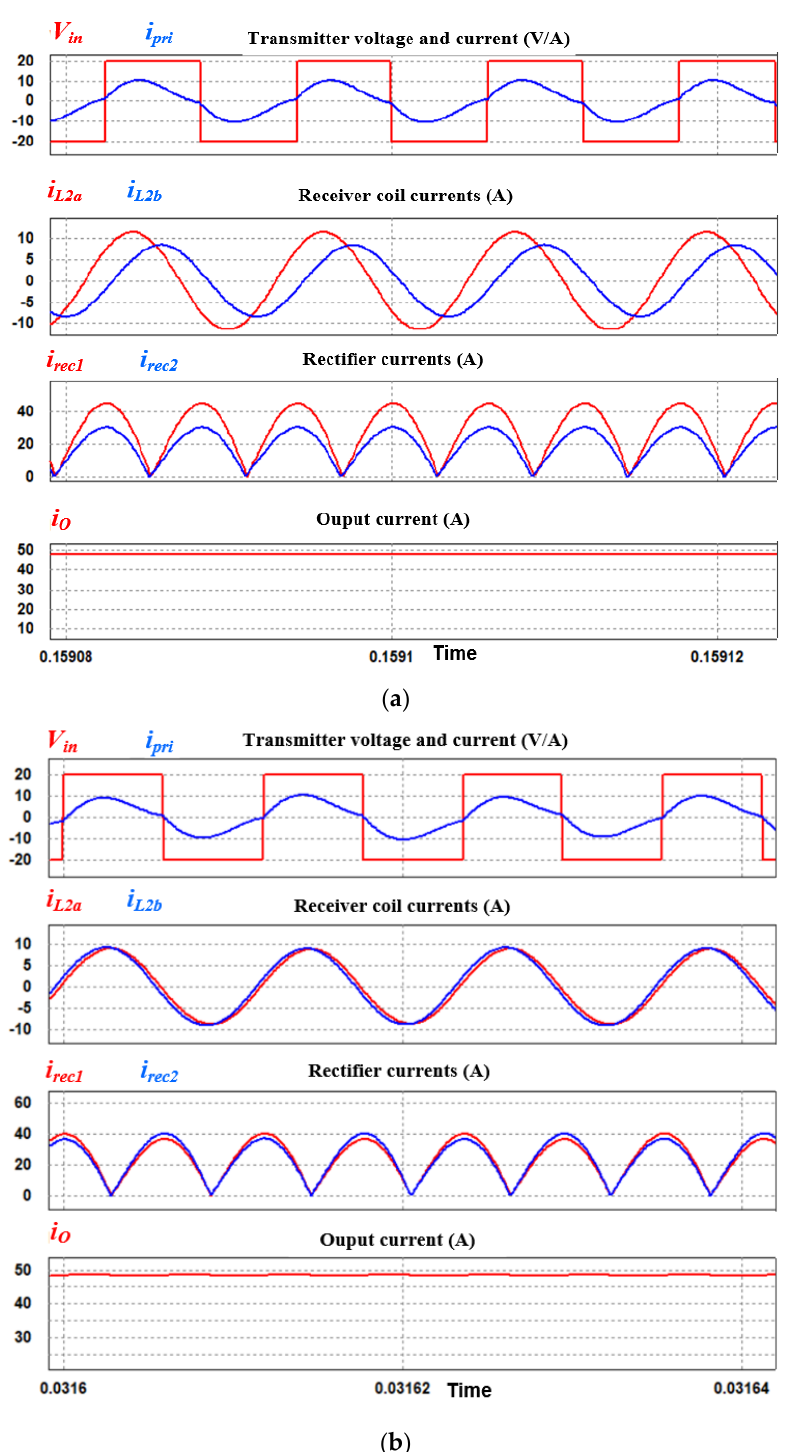
Figure 32. Key simulation waveforms of proposed IPT under misalignment and component tolerance condition: ( a ) without passive current sharing technique, and ( b ) with passive current sharing technique.